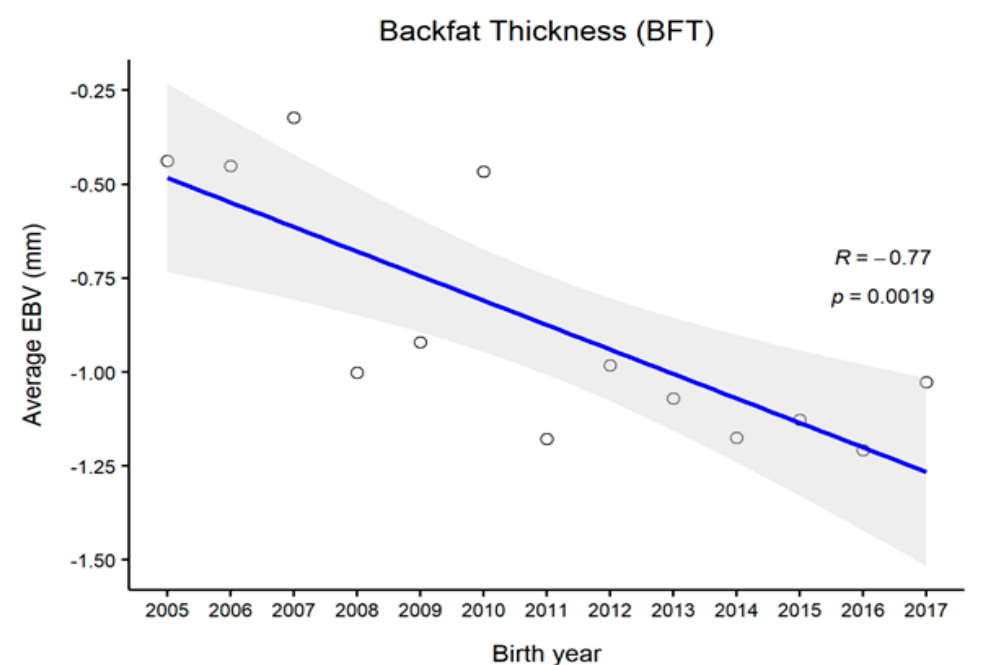
Figure 2. The genetic trend of estimated breeding values (EBVs) of the eye muscle area of Hanwoo males from the 30-month production system (R, Pearson’s correlation coefficient; p , the p -value of correlation coefficients).